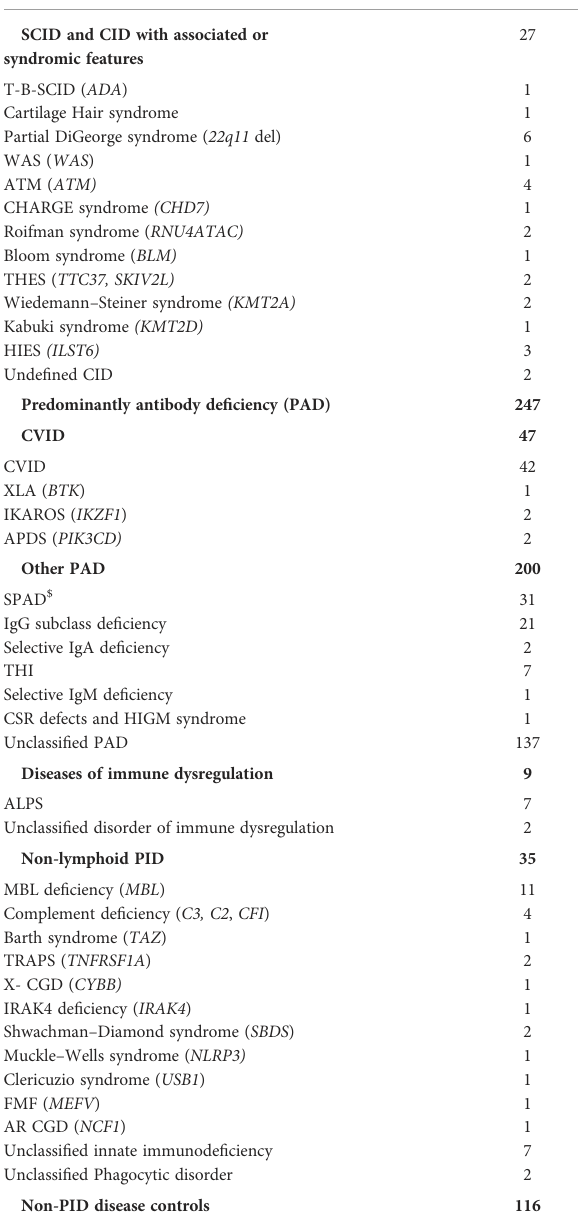
TABLE 1 PID diagnoses of the study